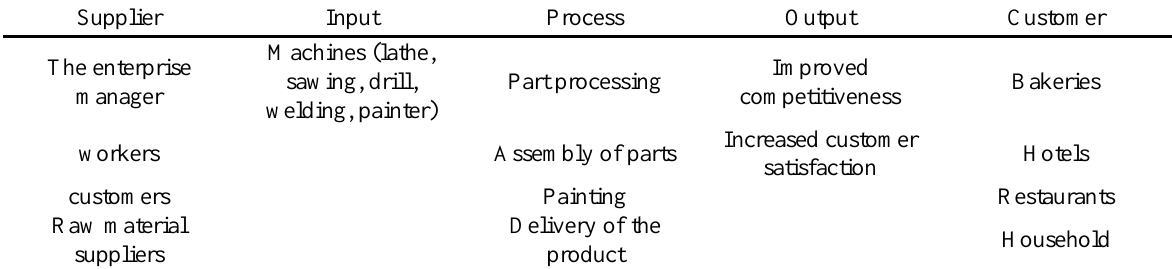
Table 1. SIPOC analysis of the current project.